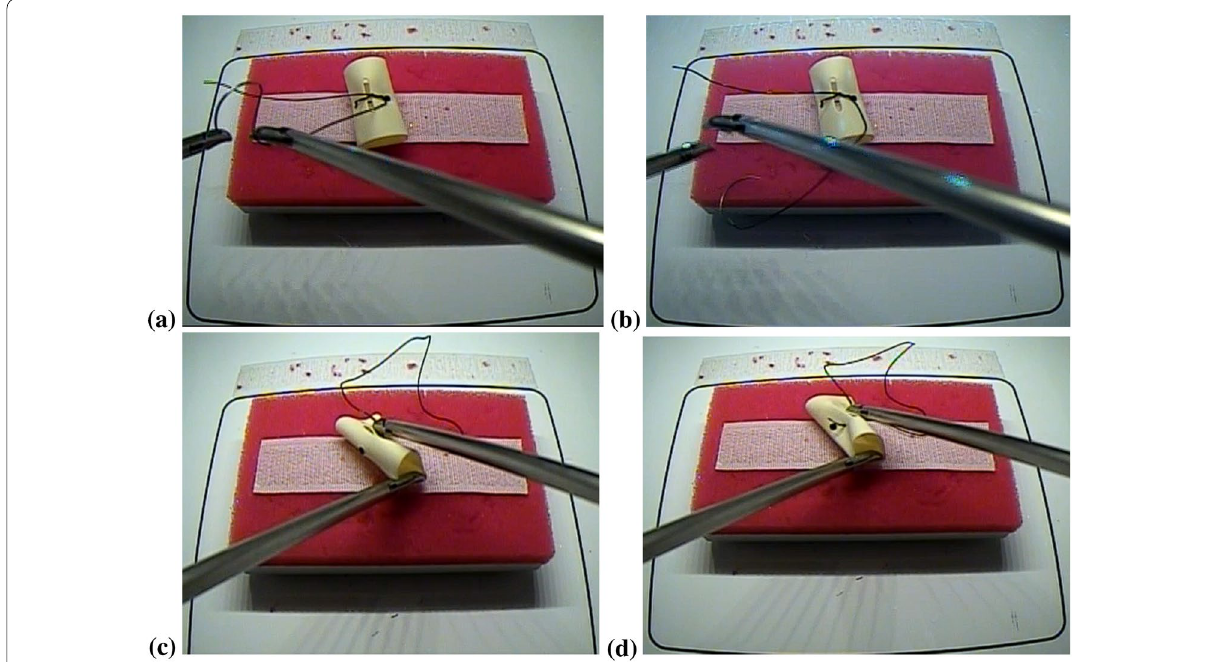
Fig. 2 a , b Image sequence showing “needle drop” error event from ( a ) to ( b ) during task performance. C, d Image sequence showing “incorrect needle insertion” error event from ( c ) to ( d ) during task